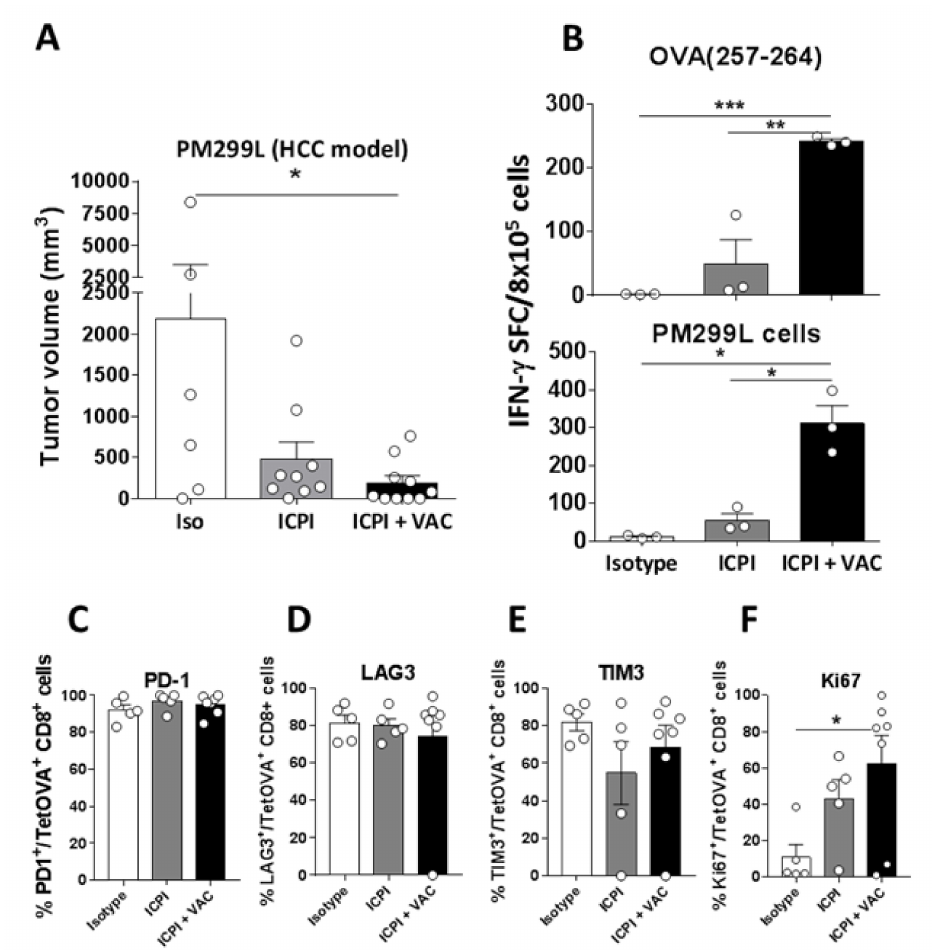
Figure 4. The CIRP-based vaccine enhances therapeutic and immune responses of ICPI-based protocols in mice with HCC. ( A ) C57BL6 / J mice ( n = 6–10 / group) were injected in the liver with 5 × 10 4